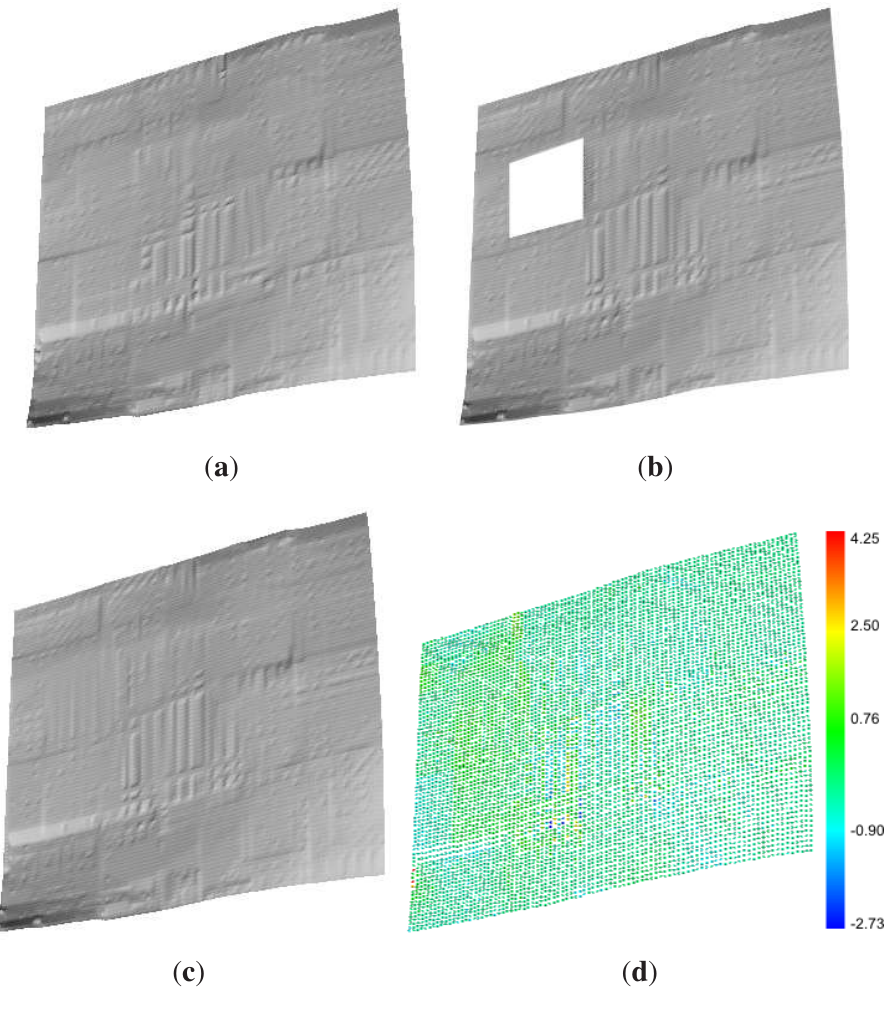
Figure 8. Filling gaps in a DTM on a level surface on a steep slope: (a) original terrain before a gap is introduced; (b) after a 40 m by 40 m gap has been introduced; (c) after the gap has been repaired; (d) a difference model showing the error in estimation between the original and estimated elevation values. The slope at this location is approximately